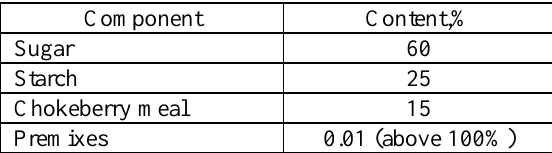
Table 2. Composition of studying mixture